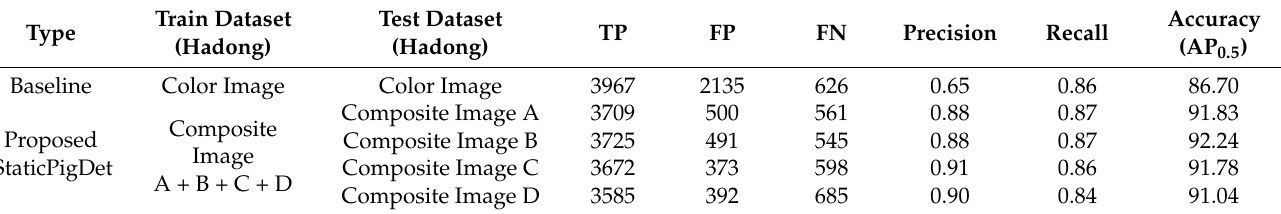
Table 3. Detection accuracy results for Hadong dataset with tinyYOLOv7 [42].